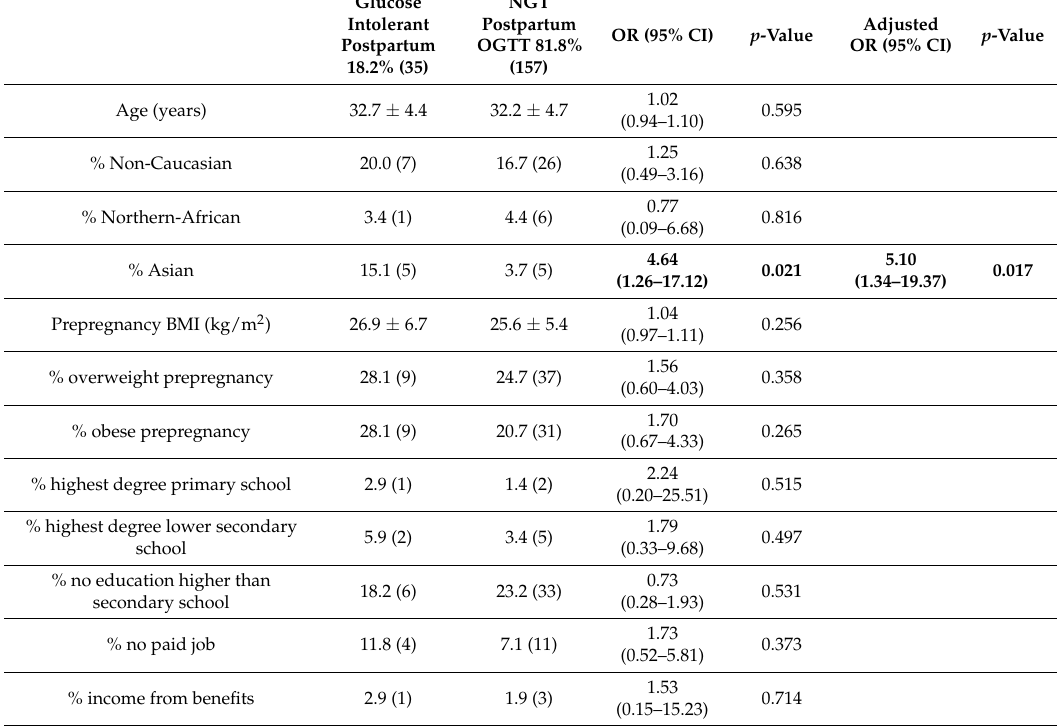
Table 2. Predictors of glucose intolerance postpartum based on general characteristics and prepregnancy risk factors.